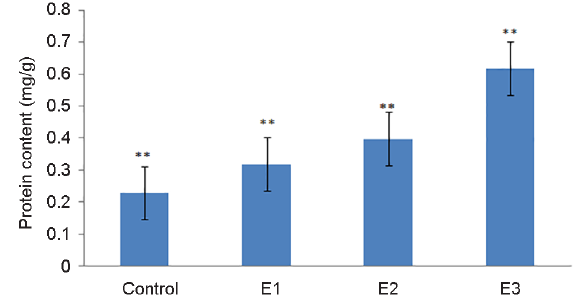
Figure 6. Comparison of protein content in different experimental plants